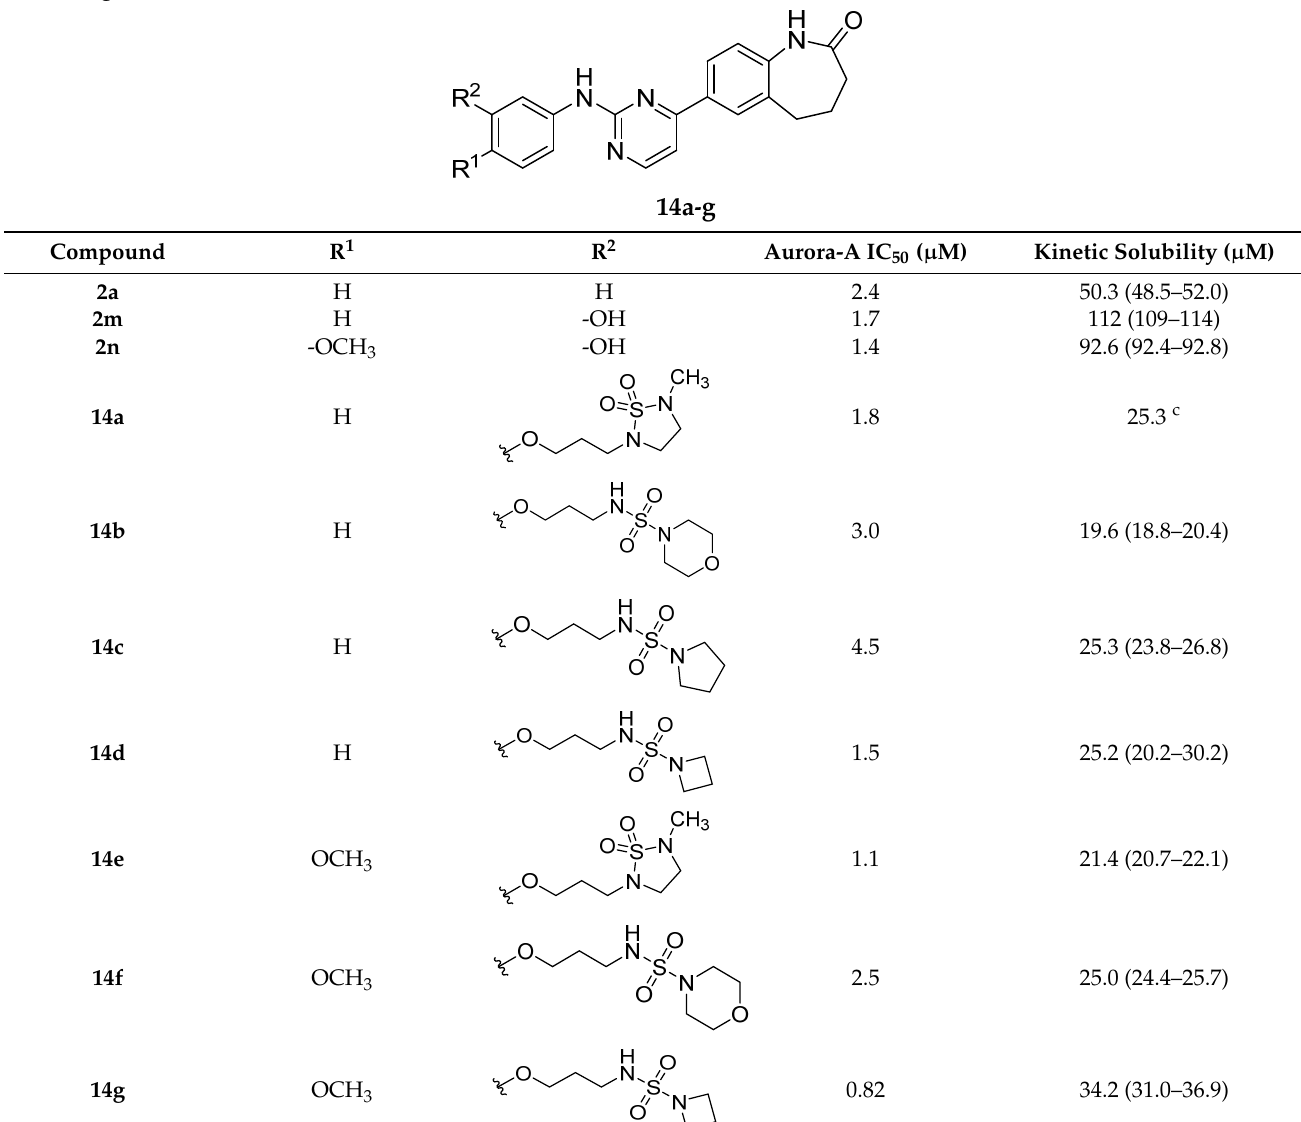
Table 4. Aurora A kinase inhibition a and kinetic solubility b of 7-(2-anilinopyrimidin-4-yl)-1-benzazepin-2-ones 2a , m , n and 14a - g .